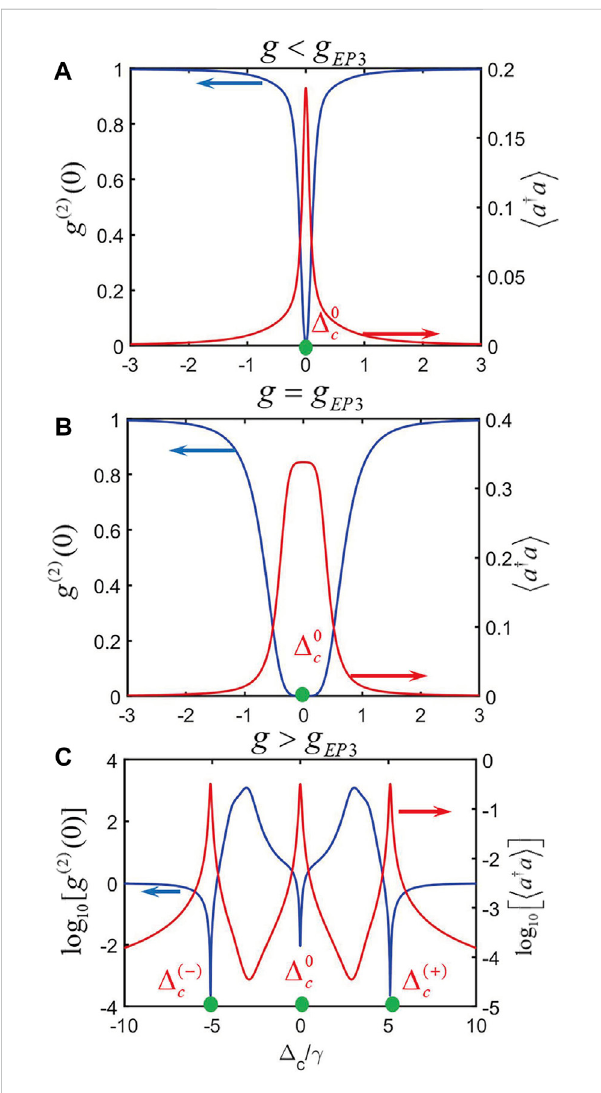
Logarithmic plots of g ( 2 ) ( 0 ) and I c as a function of the cavity frequency detuning Δ c / γ in the cases of (A) g < g EP 3 , (B) g (cid:1) g EP 3 , and (C) g > g EP 3 . The green dots represent the optimal operator regime for the realization of the strong PB phenomenon at Δ 0 c and Δ ( ± ) c